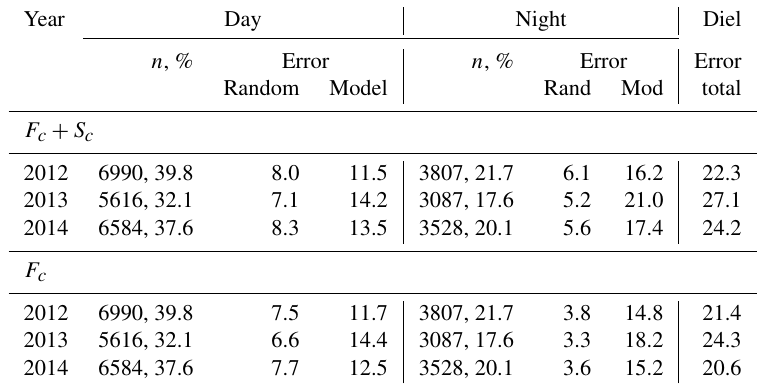
Table 6. Number of data available (after quality control and u ∗ filtering), annual uncertainty due to random and model error for daytime and nighttime, and summed annual uncertainty (gCm − 2 a − 1 ) for diel u ∗ -filtered F c and F c + S c . Year Day Night Diel n , % Error n , % Error Error Random Model